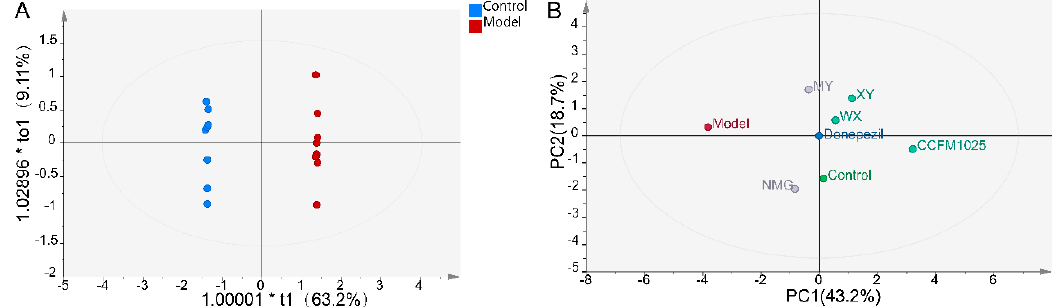
Figure 5. Statistical analysis of all significant measurements. ( A ) OPLS-DA plot for the control and model groups ( n = 6–8). ( B ) PCA score plot for all groups. The distance between two data points in the two-dimensional PCA plot is a visual representation of the similarity between different groups. Note: PCA = principal component analyses, PC1 = principal component 1, PC2 = principal component 2.